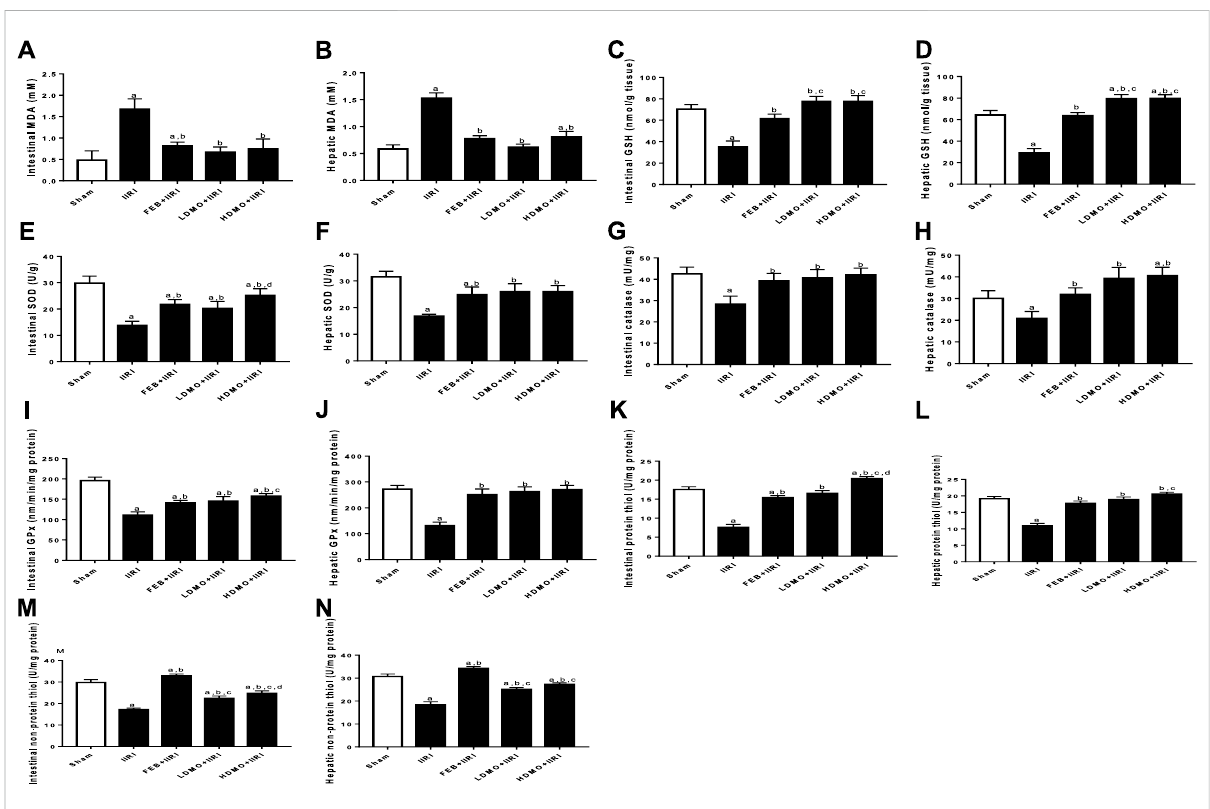
FIGURE 3 Effect of intestinal ischaemia/reperfusion (I/R) and methanolic Moringa oleifera leaf extract on markers of oxidative stress in the intestinal and hepatic tissues. MDA: Malondialdehyde, GSH: reduced glutathione, SOD: superoxide dismutase, GPx: glutathione peroxidase. IIRI: Intestinal ischaemia/reperfusion injury, FEB: febuxostat, LDMO: low dose Moringa oleifera, HDMO: high dose Moringa oleifera, a p < 0.05 versus sham, b p < 0.05versusIIRI, c p < 0.05versusFEB+ IIRI, d p < 0.05versusLDMO + IIRI.Data wereanalyzedbyone-way ANOVA followed byTukey ’ sposthoc test. Values are expressed as mean ± SD of 10 rats per